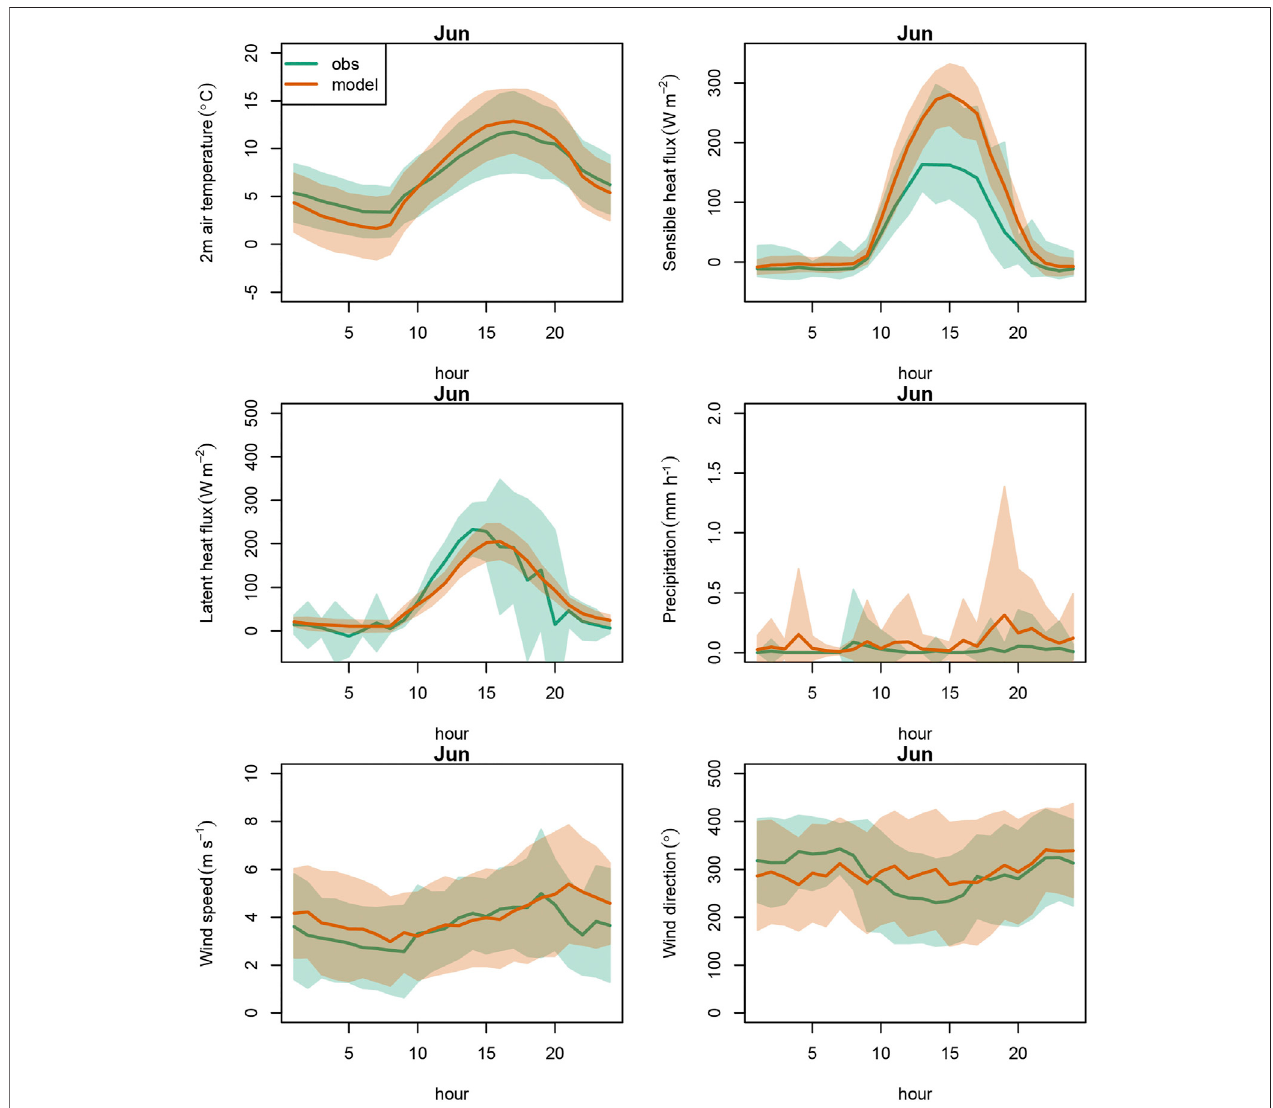
FIGURE 2 | Comparison of the June 2013 averaged diurnal cycle between the WRF simulation and the site observation. The shaded areas are the standard error during the month.